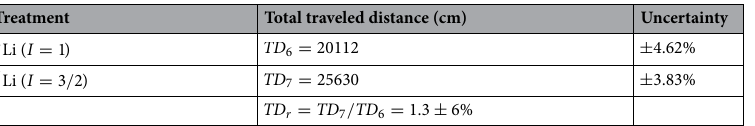
6 7 Li and Li, TD 6 and TD 7 ,